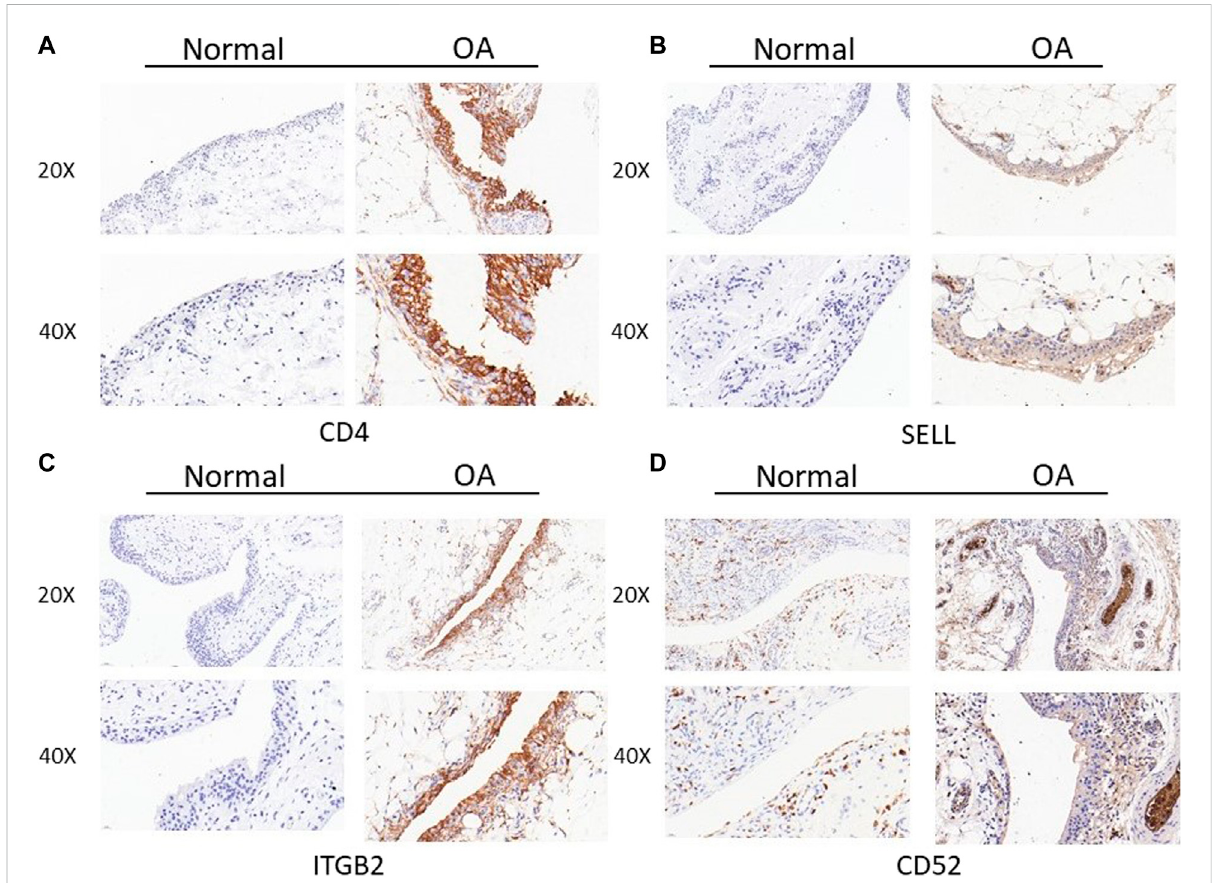
FIGURE 8 Expression of CD4, SELL, ITGB2, and CD52 proteins in clinical specimens of synovial tissues from TKA patients and patients undergoing knee arthroscopic surgery. (A) CD4, (B) SELL, (C) ITGB2, and (D)